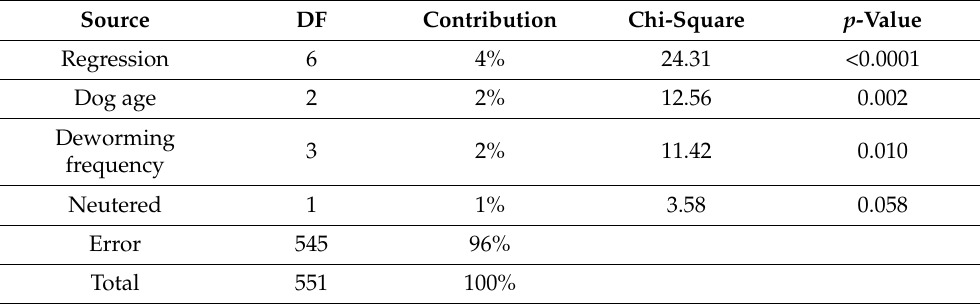
Table 6. Binary logistic regression analysis for factors that differed for owners reporting that their dog had a previous worm infection compared to those that did not have a previous infection.